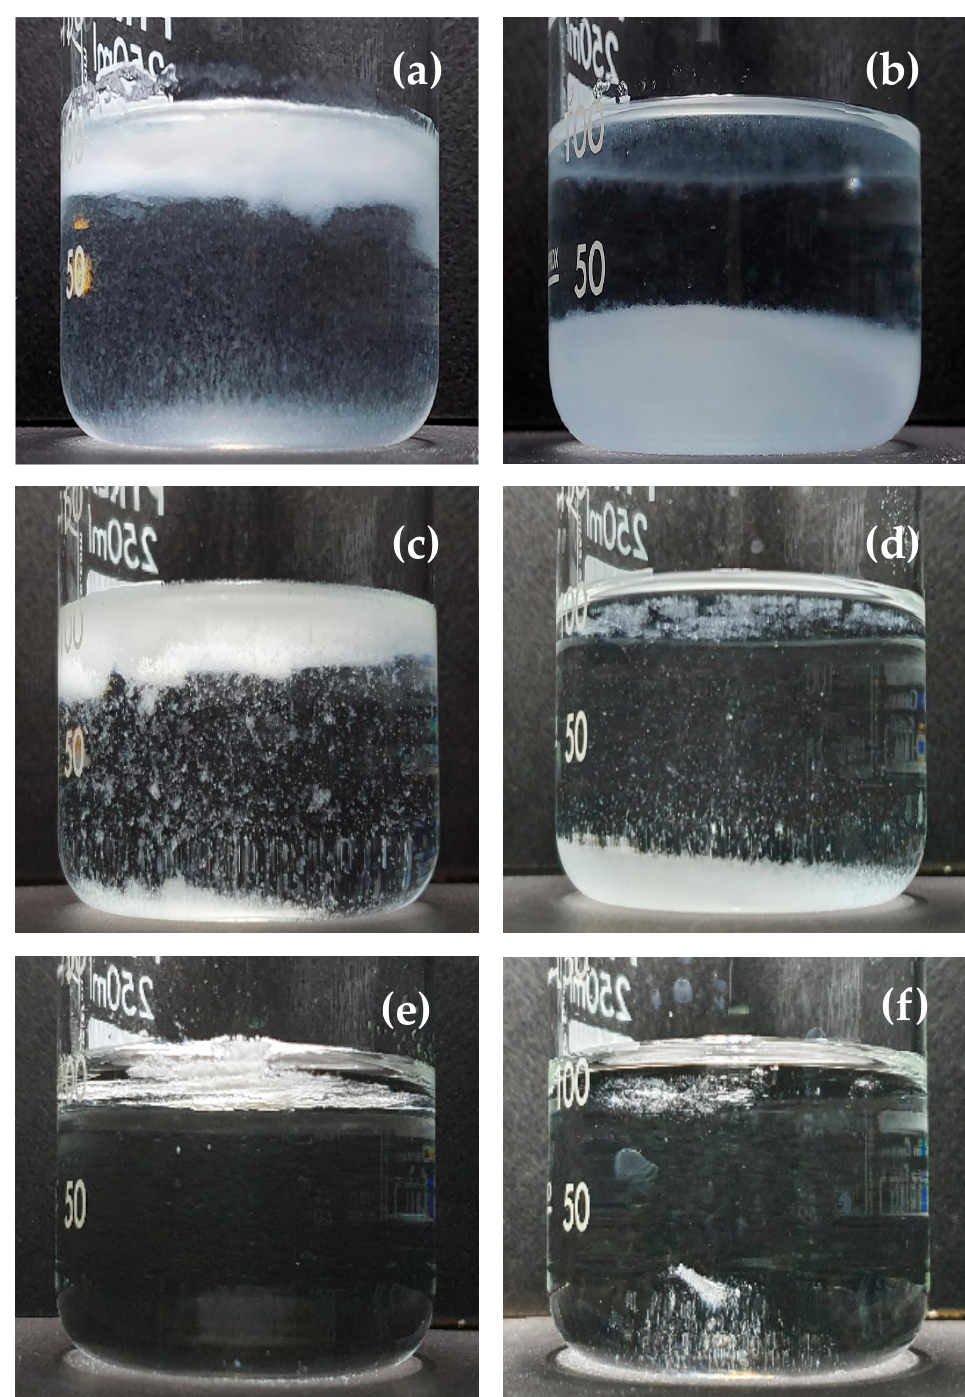
Figure 3. Water dispersibility of original fine gum powders (a-e) and gum agglomerates with sorbitol binder (b-f) in distilled water: